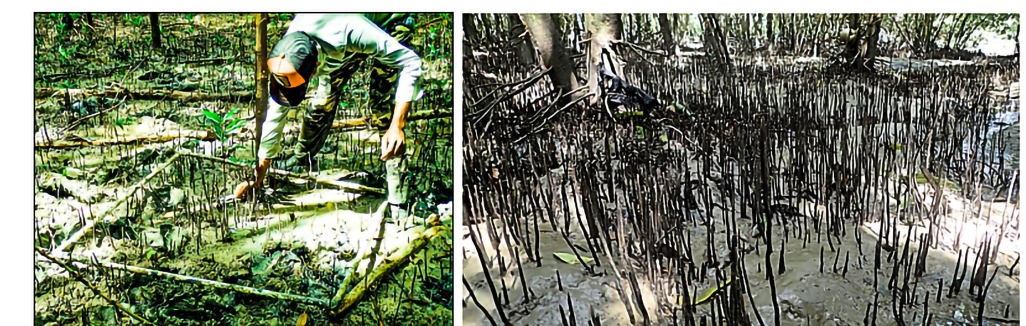
Figure 3. The setup of the vegetation quadrants and survey methodology for the vegetation data collection.